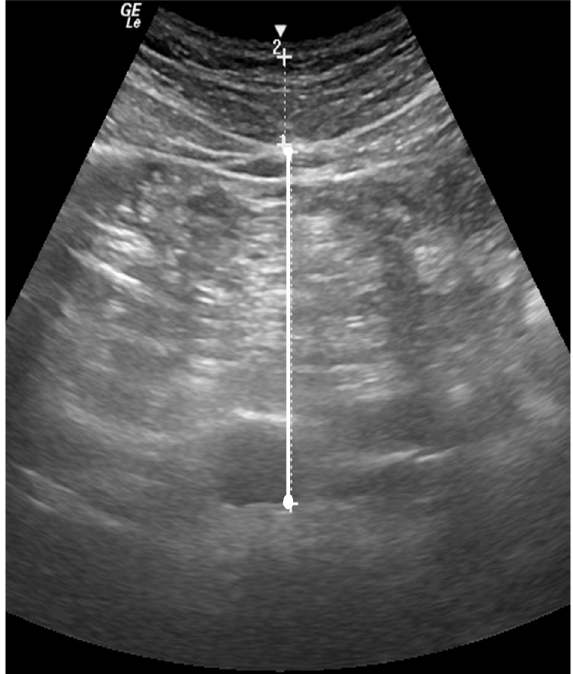
Figure 1. B-mode US image of the abdomen, 5 cm proximal to the umbilicus. The perpendicular distance between the interior border of the rectus abdominis and the posterior wall of the aorta was quantified as VAT .